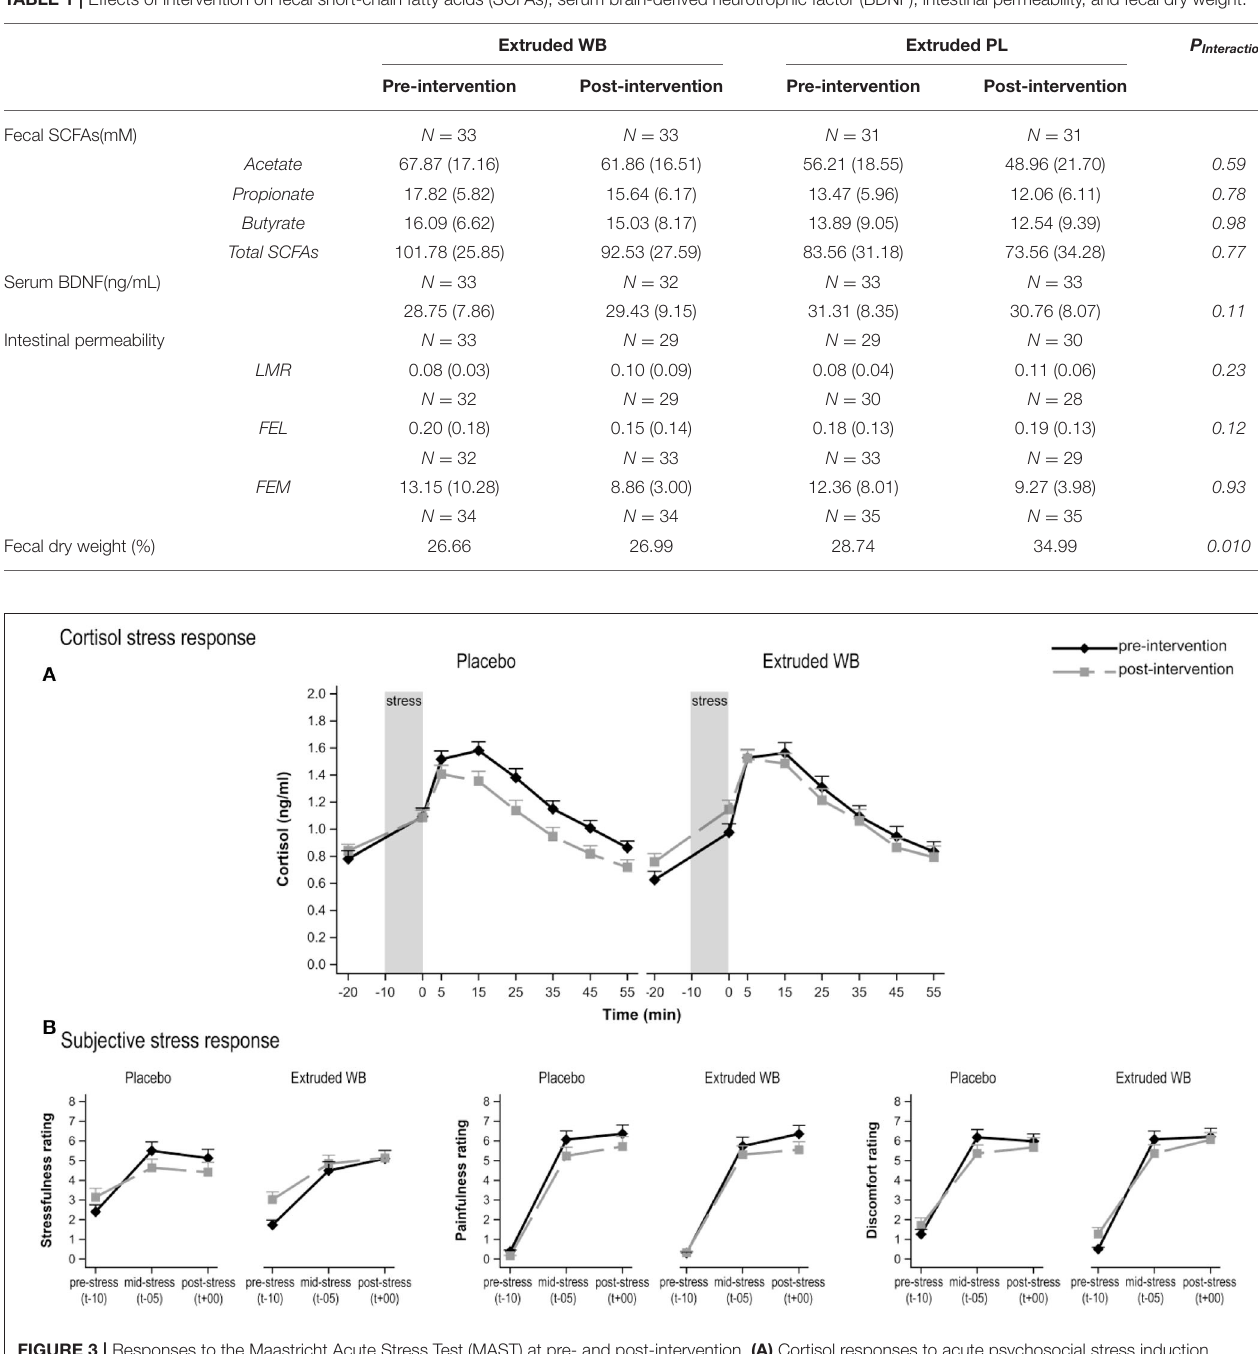
FIGURE 3 | Responses to the Maastricht Acute Stress Test (MAST) at pre- and post-intervention. (A) Cortisol responses to acute psychosocial stress induction procedure. Saliva samples were collected from 20min before the stress induction, up to 55min after stress induction. Consumption of placebo vs. extruded WB did not modulate cortisol response ( p = 0.07). (B) Subjective responses to acute psychosocial stress induction. Consumption of placebo vs. extruded WB did not modulate subjective ratings of stressfulness, painfulness, or discomfort in the middle and after the MAST relative to baseline values. Graphs show means of Box-Cox transformed cortisol (transformed_cortisol = [(cortisol + 1)**-025 – 1)/ − 0.25] concentrations and means of subjective ratings ±